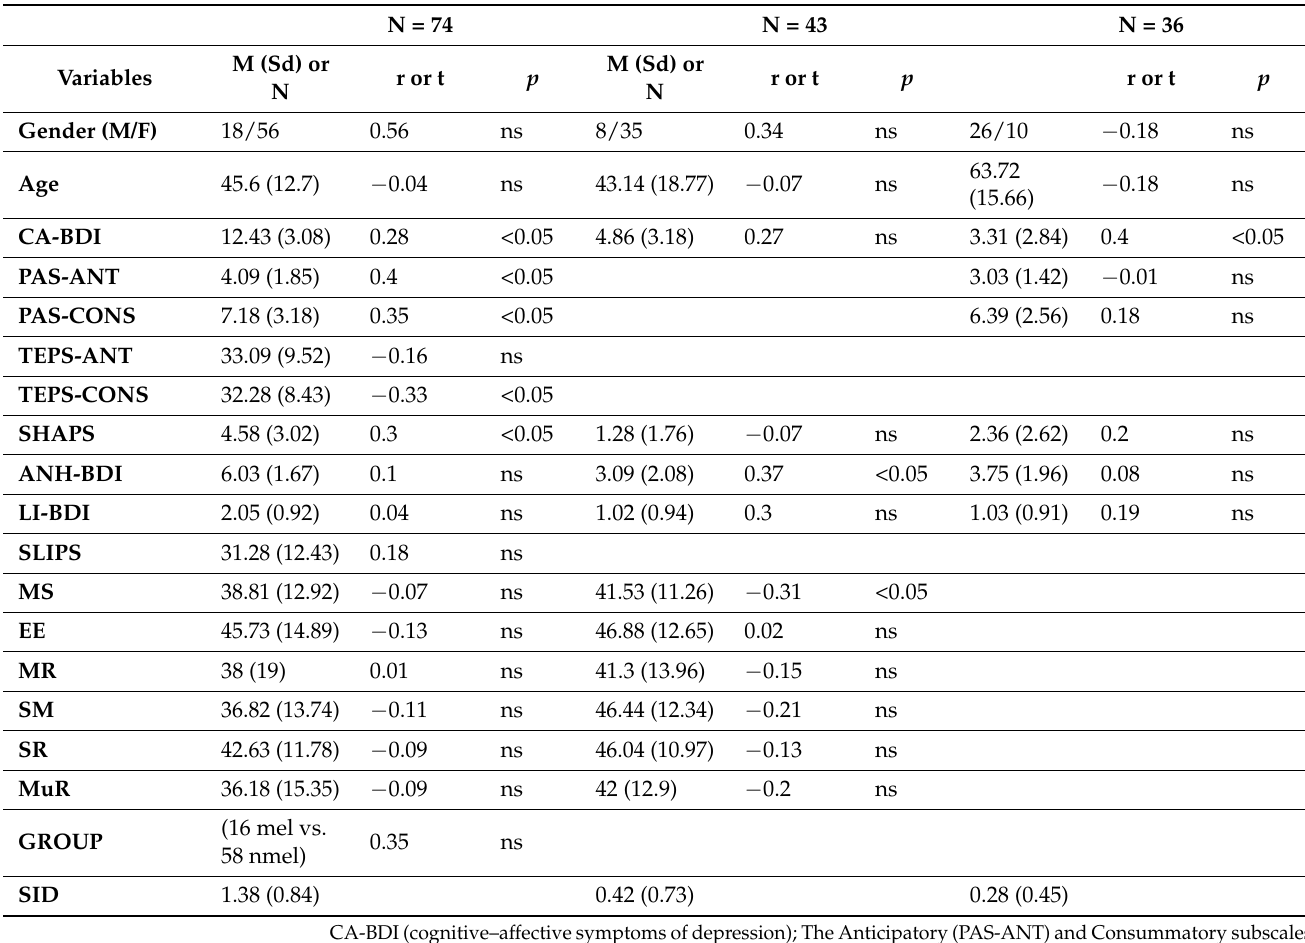
Table 1. Characteristics of the three groups (74 severe major depressives (sample 1), 43 depressives (sample 2) and 36 depressives (sample 3)) and their relationship between recent suicidal ideation and socio-demographical or psychometrical variables using the Pearson correlation coefficient (r) or Student’s t -test (t).